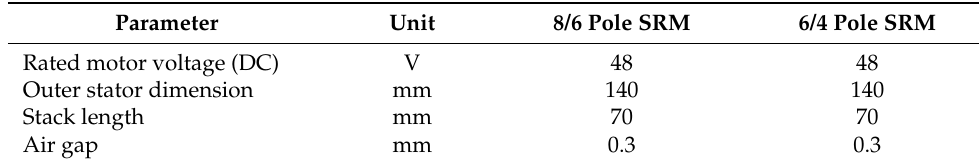
Table 2. Key initial parameters of each motor. Parameter Unit 8/6 Pole